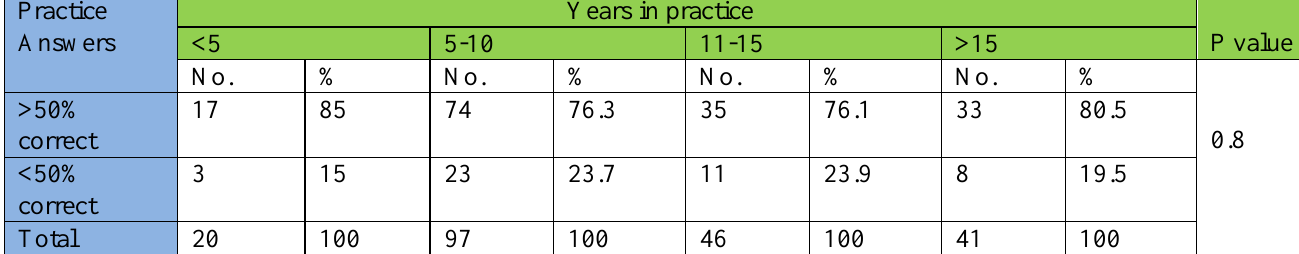
Table.10. relationships between practice category and years in practice Practice